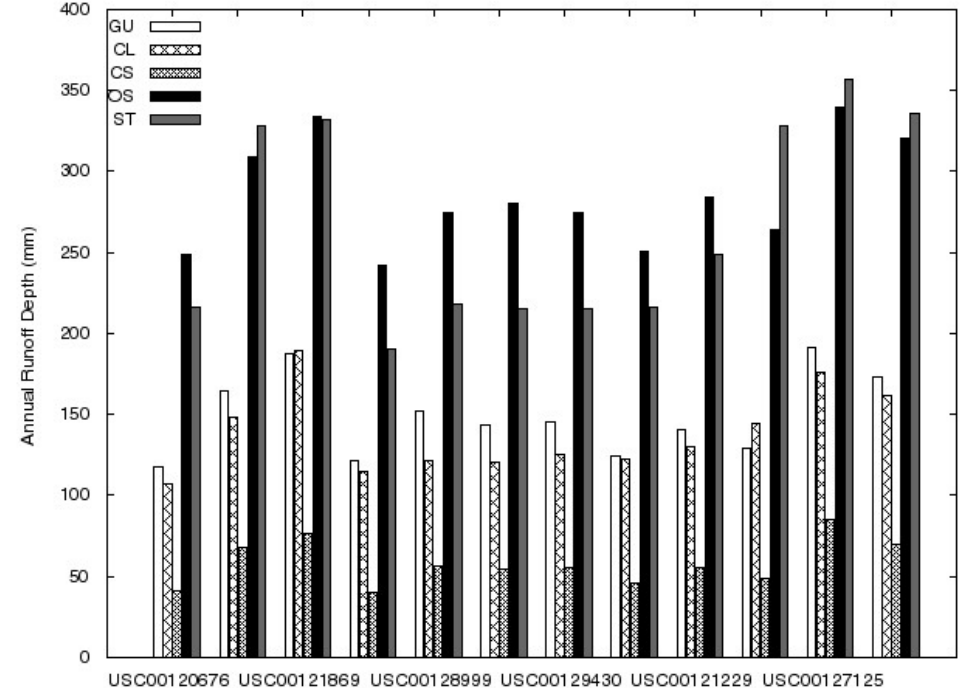
Figure 4. Comparison of average annual direct runoff by different